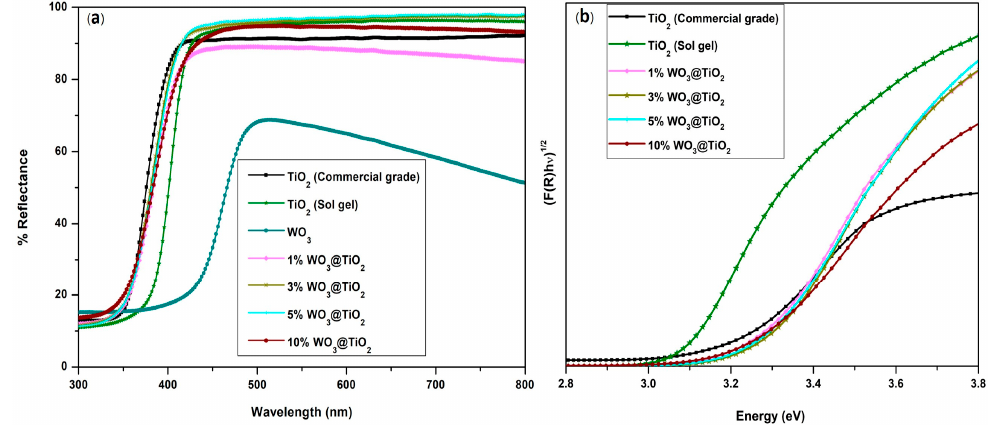
Figure 2. UV/Visible spectra ( a ) and the transferred Kubelka–Munk vs. absorption energy plots ( b ) of the various metal oxides.